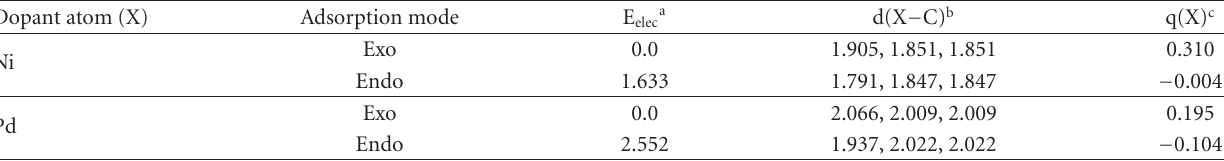
Table 2: Binding energy and geometric data for transition metal-doped SWCNTs